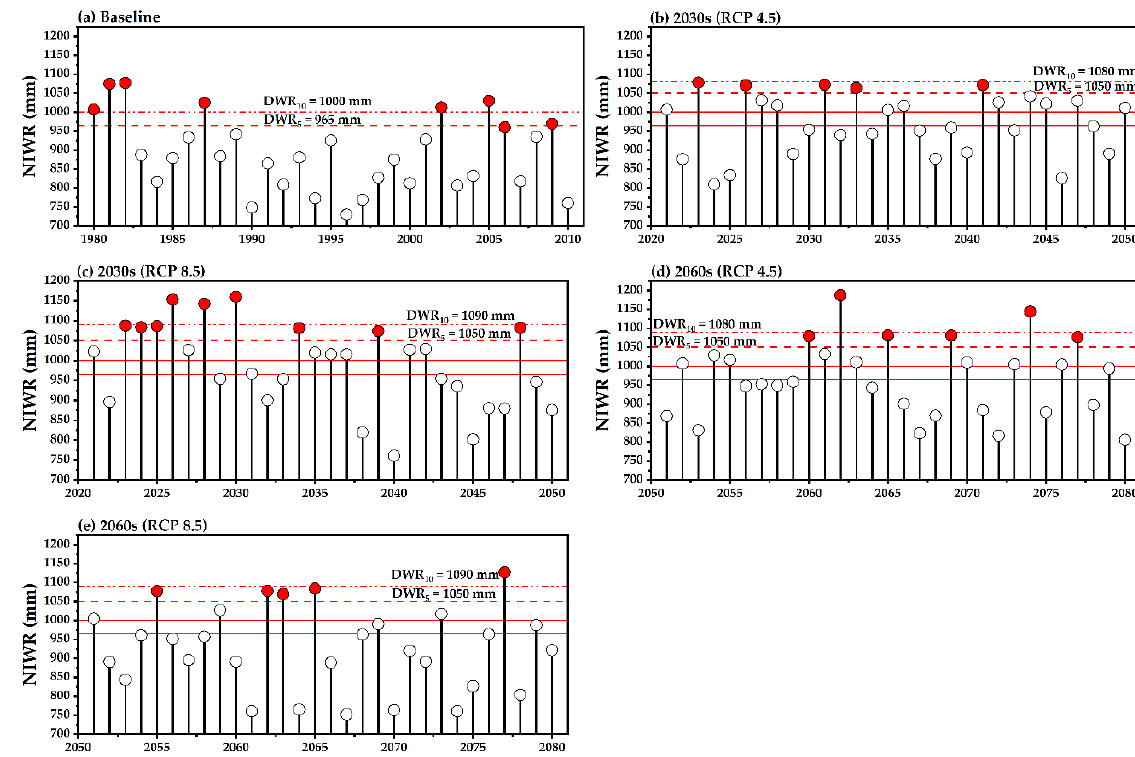
Figure 9. Design water requirements for the 5- and 10-year return period drought (DWR 5 and DWR 10 , respectively) during the ( a ) baseline (1980 − 2010), ( b , c ) 2030s (2021 − 2050), and ( d , e ) 2060s (2051 − 2080). The solid horizontal lines in Figure 9 ( b – e ) represent DWR 5 and DWR 10 during the baseline.